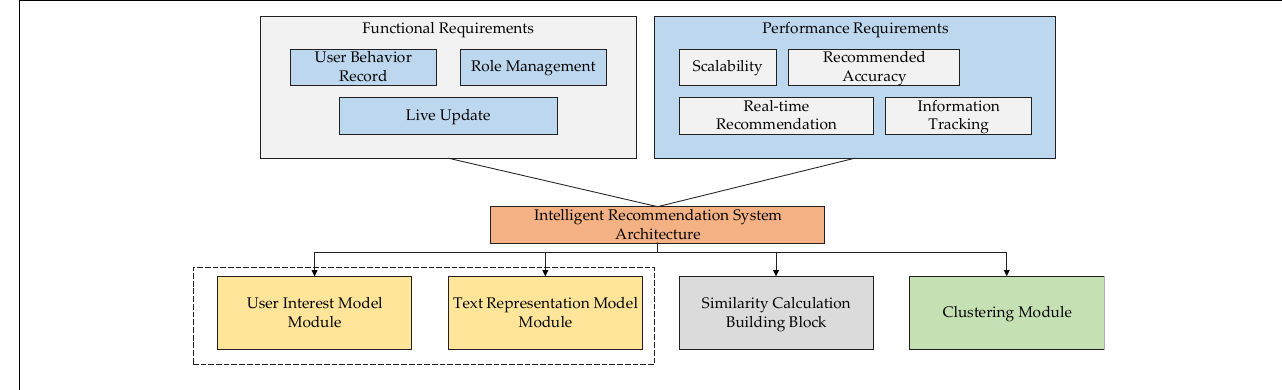
FIGURE 3 | Framework of the proposed IRS.